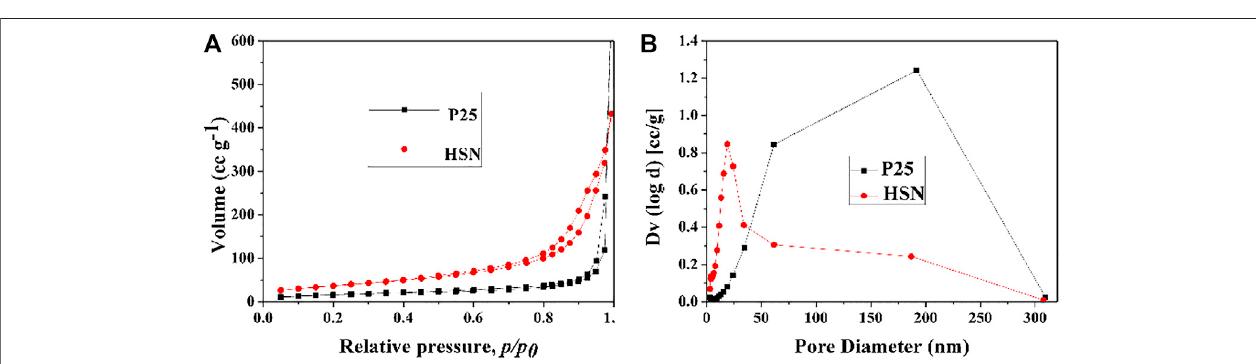
Frontiers in Energy Research |